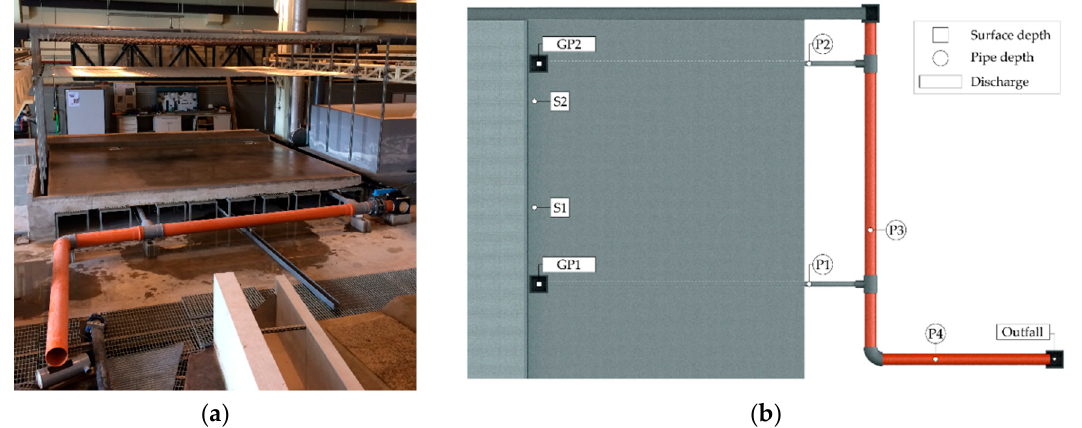
Figure 7. ( a ) Physical model facility and ( b ) measuring points in inlets, pipes and surfaces used for results validation.